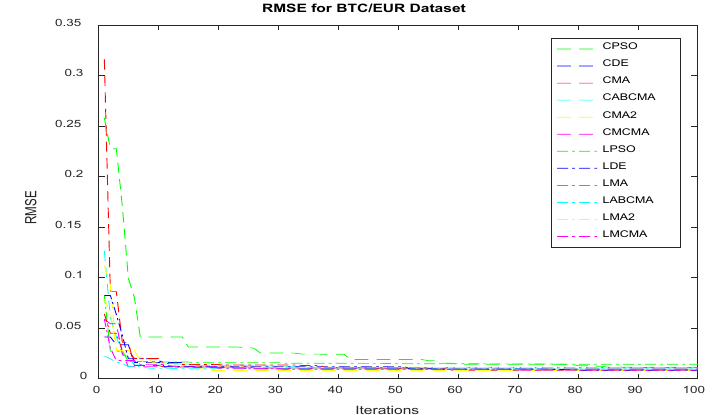
Figure 10. RMSE plot for BTC/EUR dataset.